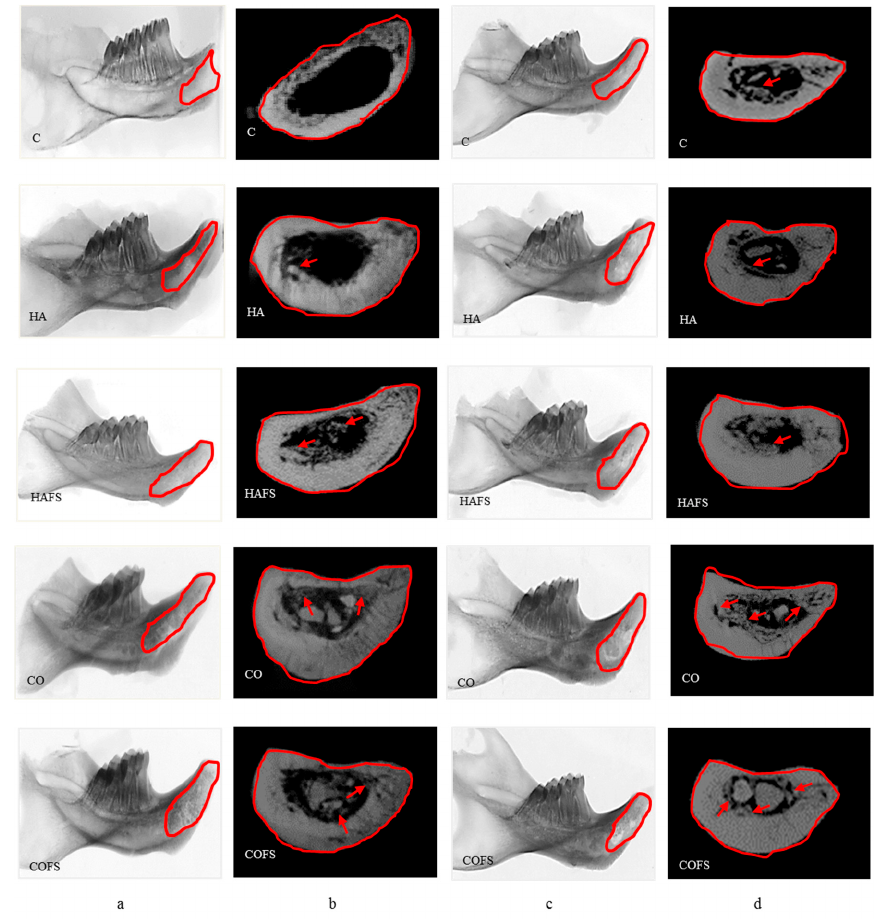
Figure 5. Micro-CT images of the lower right incisor extraction sockets: ( a ) in the horizontal plane at two weeks; ( b ) in the vertical plane at two weeks; ( c ) in the horizontal plane at four weeks; and ( d ) in the vertical plane at four weeks.